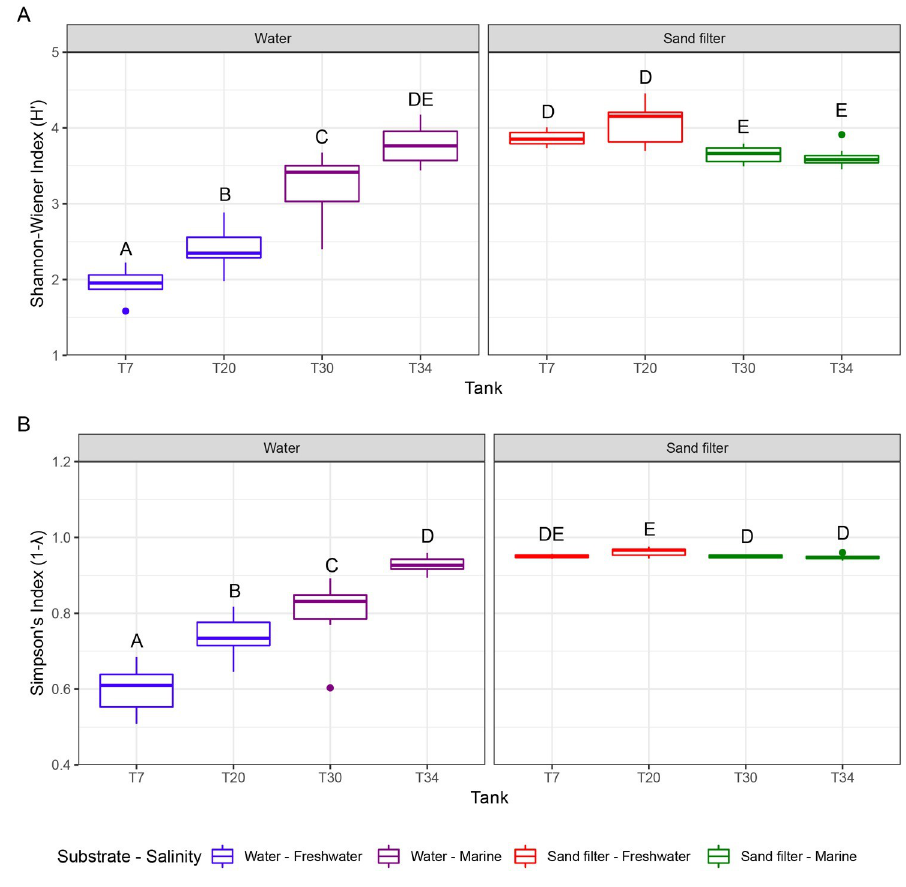
Fig 1. Shannon-Wiener Diversity (A) and Simpson’s Diversity (B) estimates for all Tennessee aquarium habitat microbial communities. Plots represent samples taken over the one-month data collection period with two substrate types (water and sand filter) represented per tank and depict the median (bold line), 25th and 75th percentiles (box), 1.5 times the interquartile ranges (whiskers), and outliers (dots). Letters represent significant differences (p � 0.01) between samples determined by pairwise Wilcoxon tests for each diversity index. Samples labeled with different letters indicate statistically significant differences between them while samples with shared letters have no statistical